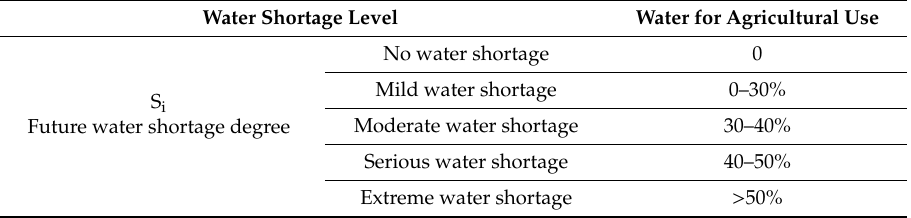
Table 12. Water Source Situation in the Irrigation